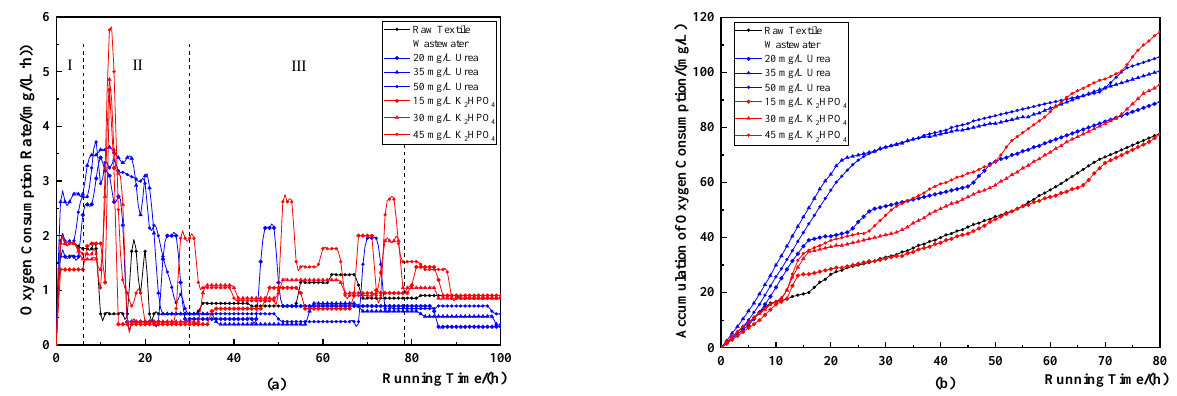
Figure 6. Oxygen consumption process curve of textile wastewater under different nutrient sources (( a ) Oxygen consumption rate; ( b ) Cumulative oxygen consumption). In the case of using nitrogen source alone, the average oxygen consumption rate of Table 5. Degradability of organic matter (calculated as COD) after adding different the 35 mg/L concentration group is the highest at the stage I, which is 2.68 mg/(L·h), 33.18% higher than the 45 mg/L concentration group. The blank group and the 20 mg/L concentration group do not have a rapid degradation stage. After 5 h of reaction, the ox- ygen consumption rate of all the treatment groups with the addition of nitrogen source further increased. The oxygen consumption rate of the 35 mg/L concentration group